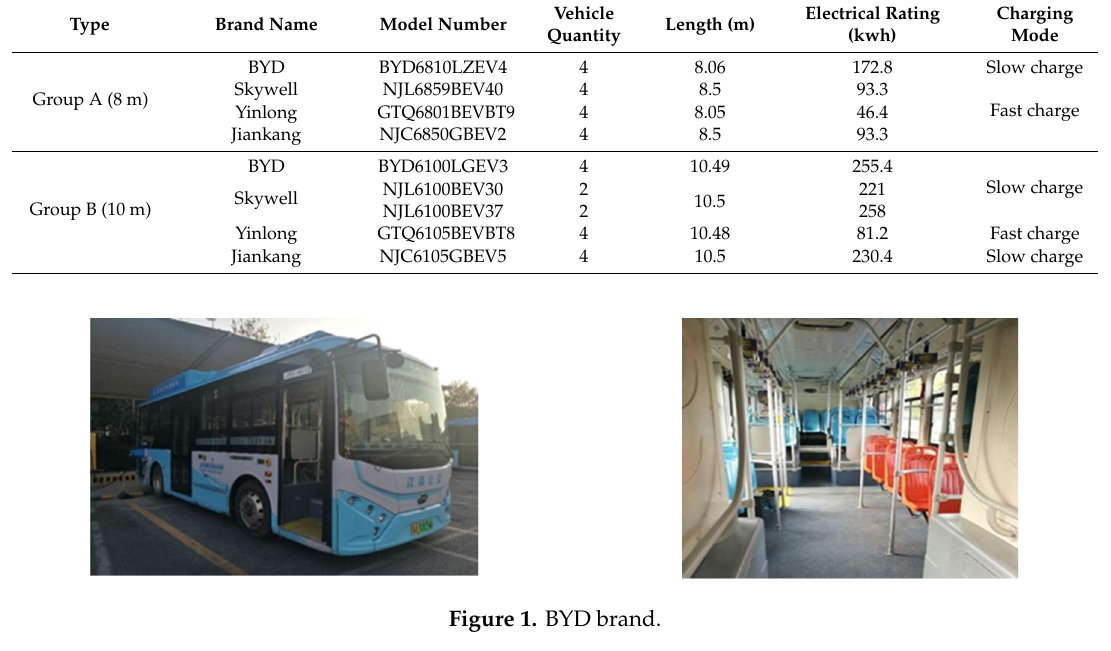
Table 1. Vehicle Brand Involved in the Test.